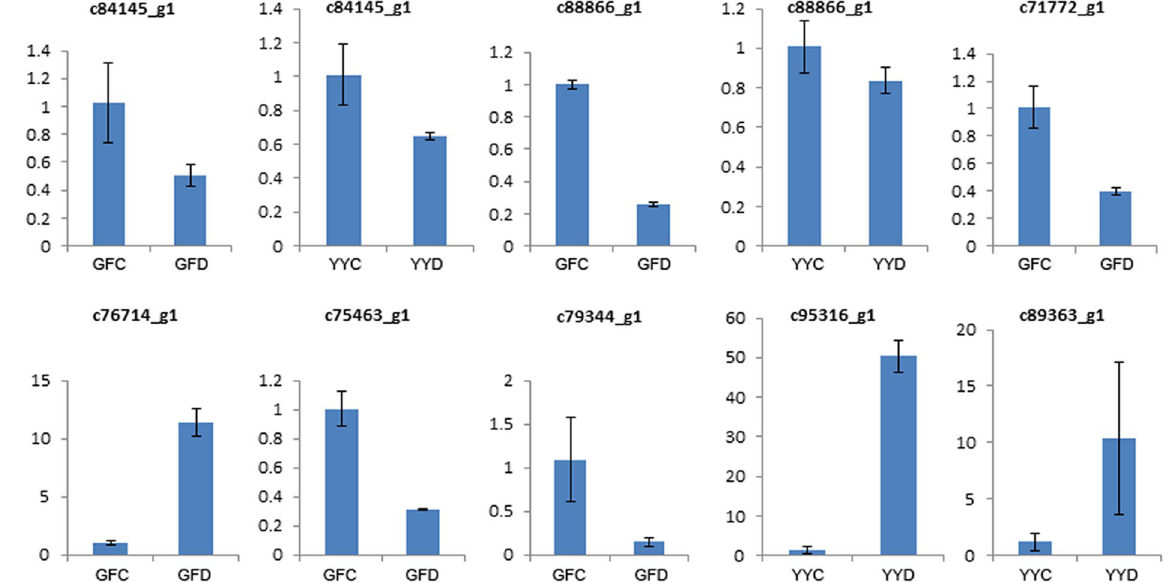
Figure 6. qRT-PCR analysis of eight differentially expressed unigenes. Data represent the fold change of relative quantification of each DEG in GFD (GF drought-stressed) vs. GFC (GF control) or YYD (YY drought-stressed) vs. YYC (YY control); the error bar represents the standard